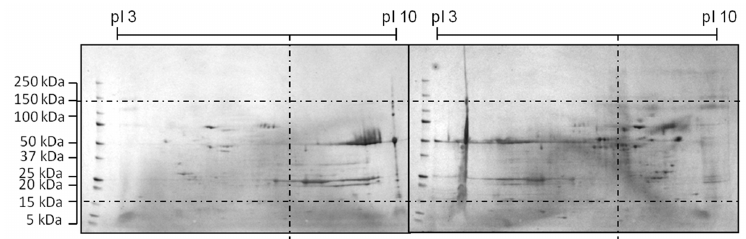
Figure 5. Comparison of 2D ‐ SDS PAGE of a reference ( right ) and optimized medium ( left ) during a CHO cultivation according to [47]. Media was improved by a three ‐ level DoE